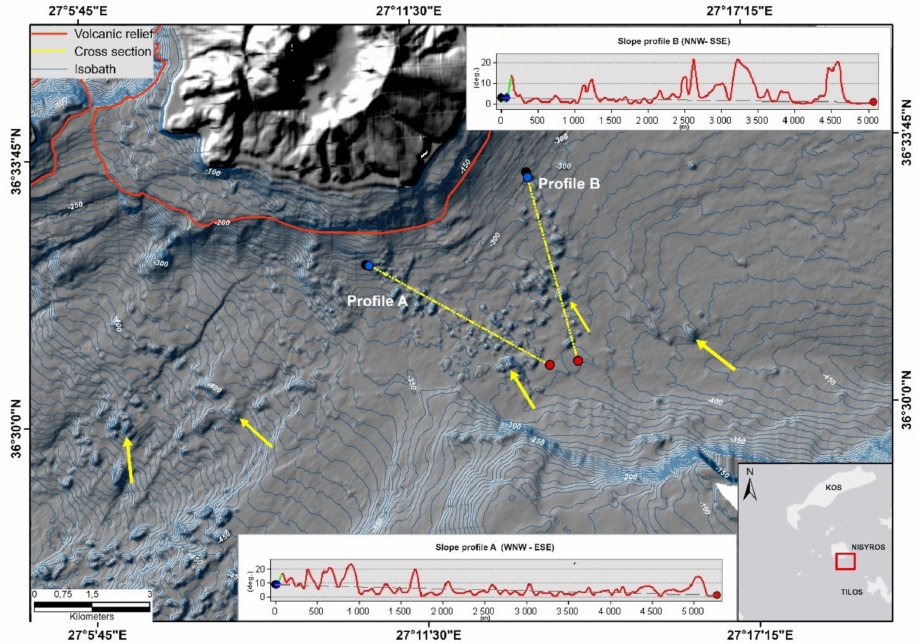
Figure 10. Hillshade map of the SE Nisyros submarine area, with 10 m isobaths, depicting a part of the volcanic debris avalanche field. The larger hills/hummocks are shown as closed isobaths in the map (yellow arrows). Slope profiles (in degrees) along the debris avalanches interpret their shape to horizontal